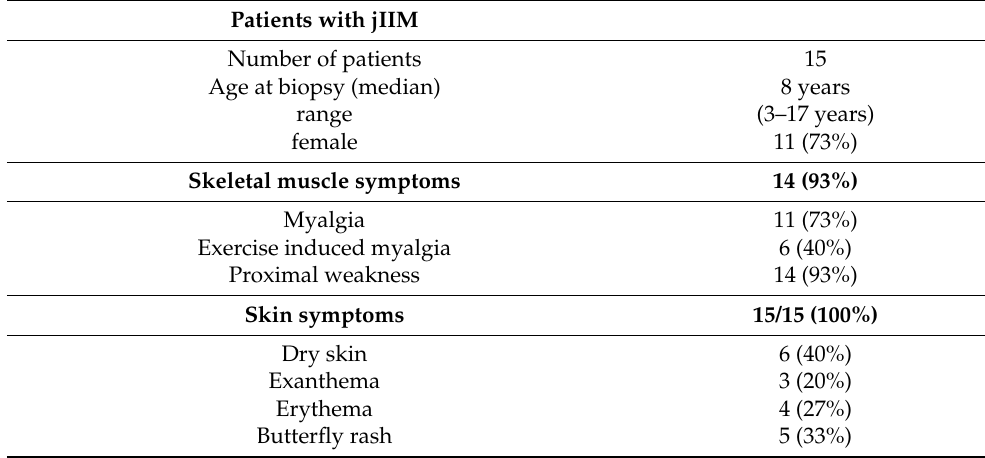
Figure 2. Proximal myopathy and skin lesions are the clinical hallmarks in patients with jIIM. Mild facial erythema ( A ) and discrete erythematous papules overlying the metacarpal joints (Gottron’s papules) ( B ) in a 16-year-old girl with DM (P5). Coronal MR images in a 10-year-old patient with anti-NXP2 antibody-associated DM (P4) showing mild contrast enhancement in T1-weighted images and diffuse oedema of the thigh muscles at first presentation (arrows) ( C ) resolving completely with treatment after 6 ( D ) and 12 months ( E ). Table 1. Summary of demographic data of patients with jIIM.